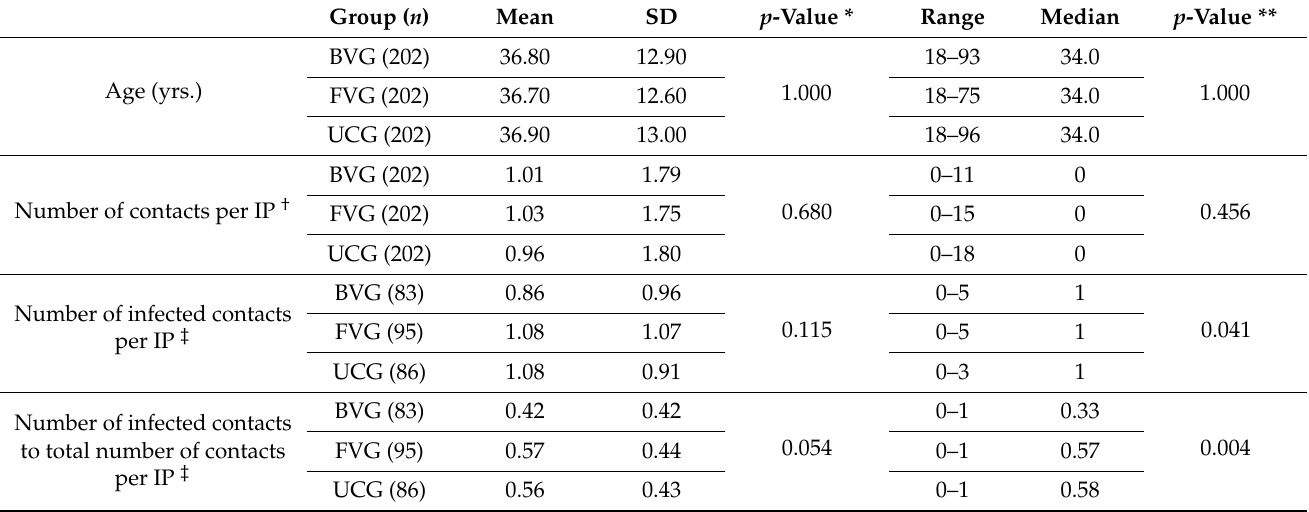
Table 1. Total contacts, total infected contacts and related to total number per infected persons (IP) in the booster-vaccinated group (BVG) vs. the fully vaccinated group (FVG) vs. the unvaccinated control group